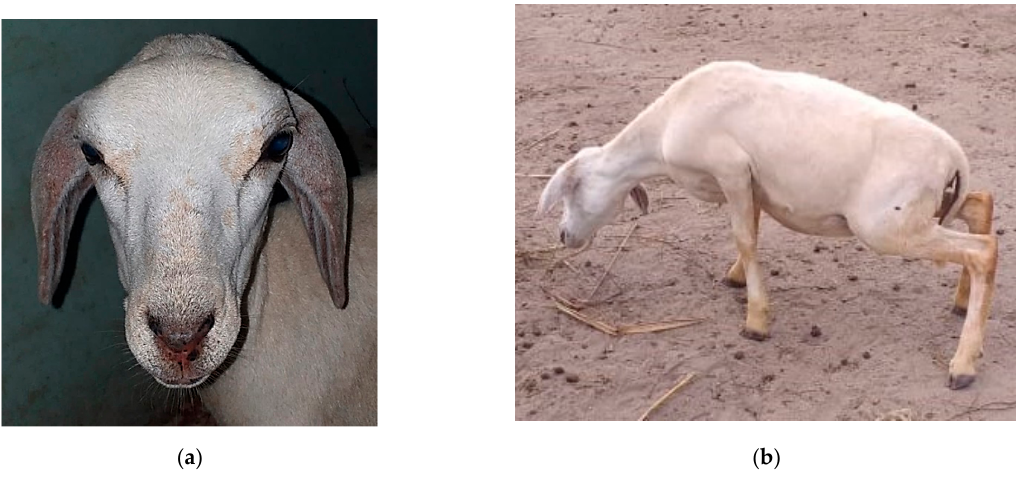
Figure 2. Experimental poisoning by Chamaecrista serpens in sheep. Ov2 from G1. Day 5. ( a ) Facial eczema. ( b ) Postural change (sign of pain) and walking in circles.